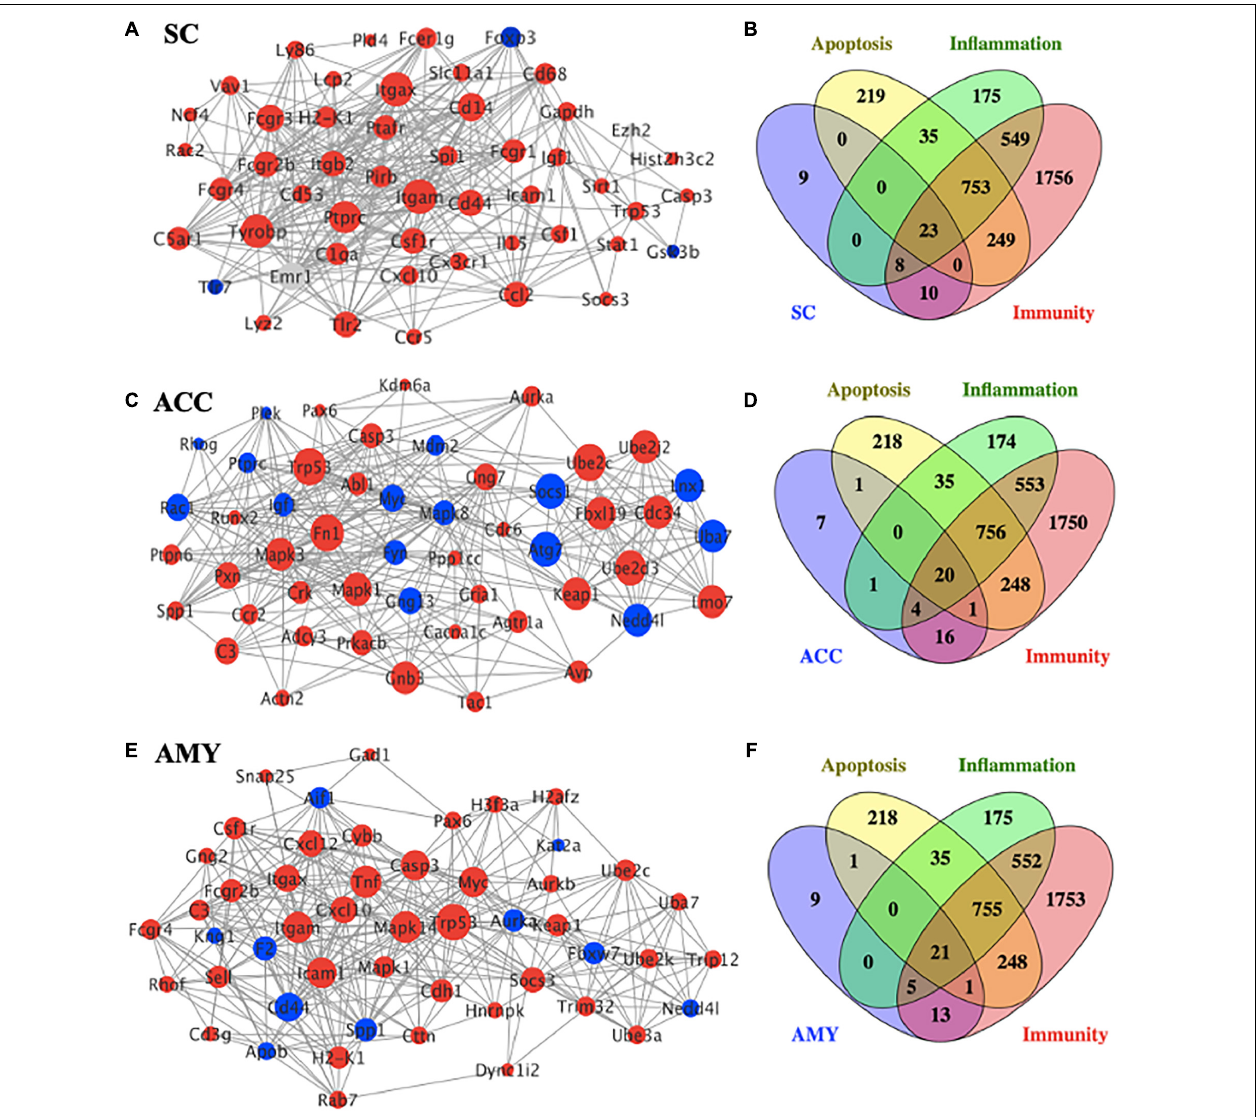
FIGURE 7 | PPI network establishments to analyze protein–protein interactions. ( A , C , E ) Top 50 differentially expressed genes (DEGs) were picked out based on the connection degree of genes and constructed the network in the SC (A) , ACC (C) , and AMY (E) . The size of the node represents the connection degree that indicates the importance of the gene in the network. Red and blue colors represent the up- and downregulated genes, respectively. ( B , D , F ) Venn diagrams indicated the number and proportion of the selected top 50 DEGs mapped to apoptosis-, inflammation-, and immunity-related genes in the SC (B) , ACC (D) , and AMY (E) ,